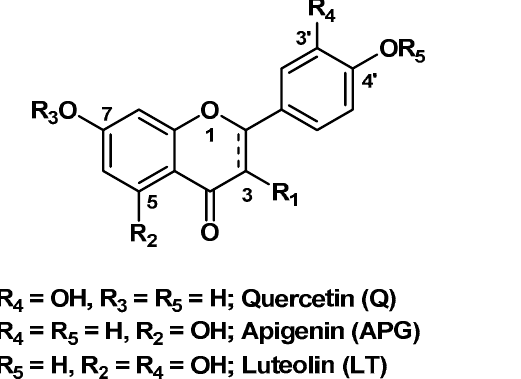
Figure 3. Chemical structure of quercetin (Q) and some related natural occurring flavonoids. Jangde R. et al. proposed a layered HG film composed of Carbopol HG loaded with Q-containing liposomes and G. This multiphase HG system with the optimal ratio G/Carbopol of 6:4 accelerated